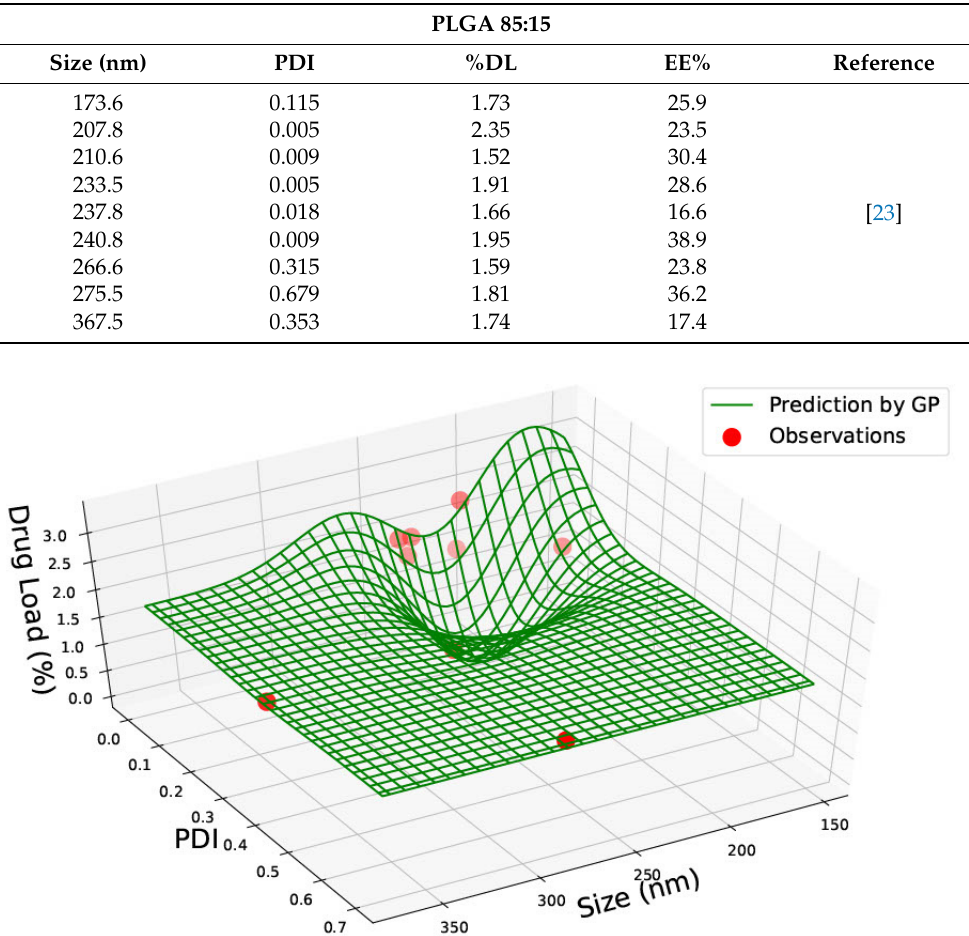
Figure 10. PLGA 85:15—graph representing size (nm), Polydispersity Index (PDI) and Drug Load (DL%).